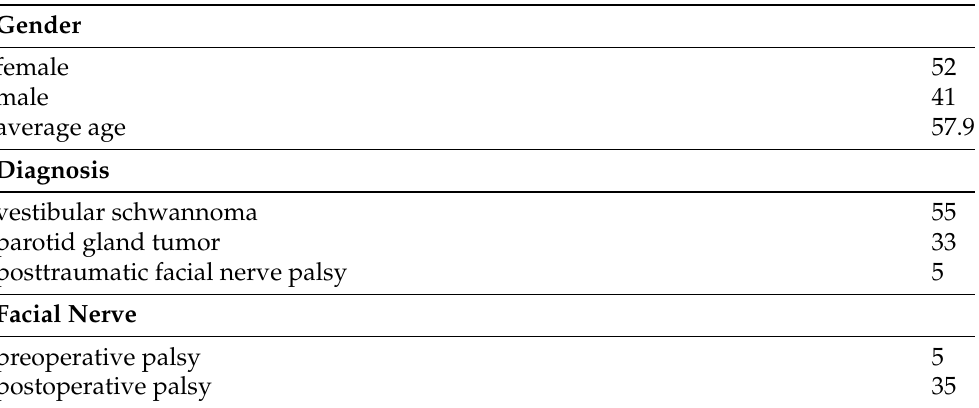
Table 2. Dataset: patients.